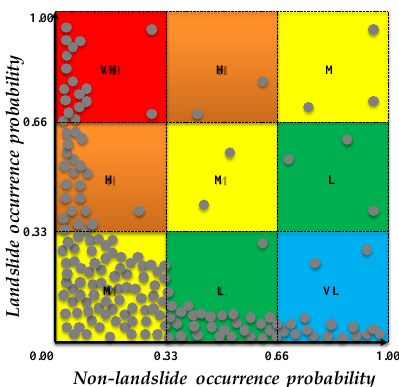
Figure 3. The proposed If-Then rules based on a 2D scatter plot to classify the outcomes of landslide and non-landslide occurrence probability (resistance). Here, VH, H, M, L, and VL stand for very high, high, moderated, low, and very low susceptibilities. Grey points represent sample pixels of LSM for demonstration.